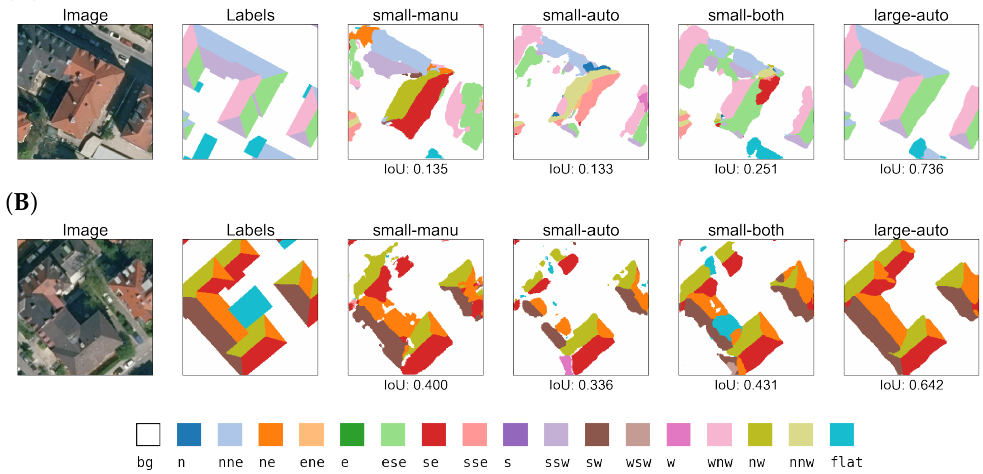
Figure 8. Test samples from the large-scale dataset large-auto at two locations ( A , B ), and corresponding predictions from all models. IoU with respect to labels is given for each